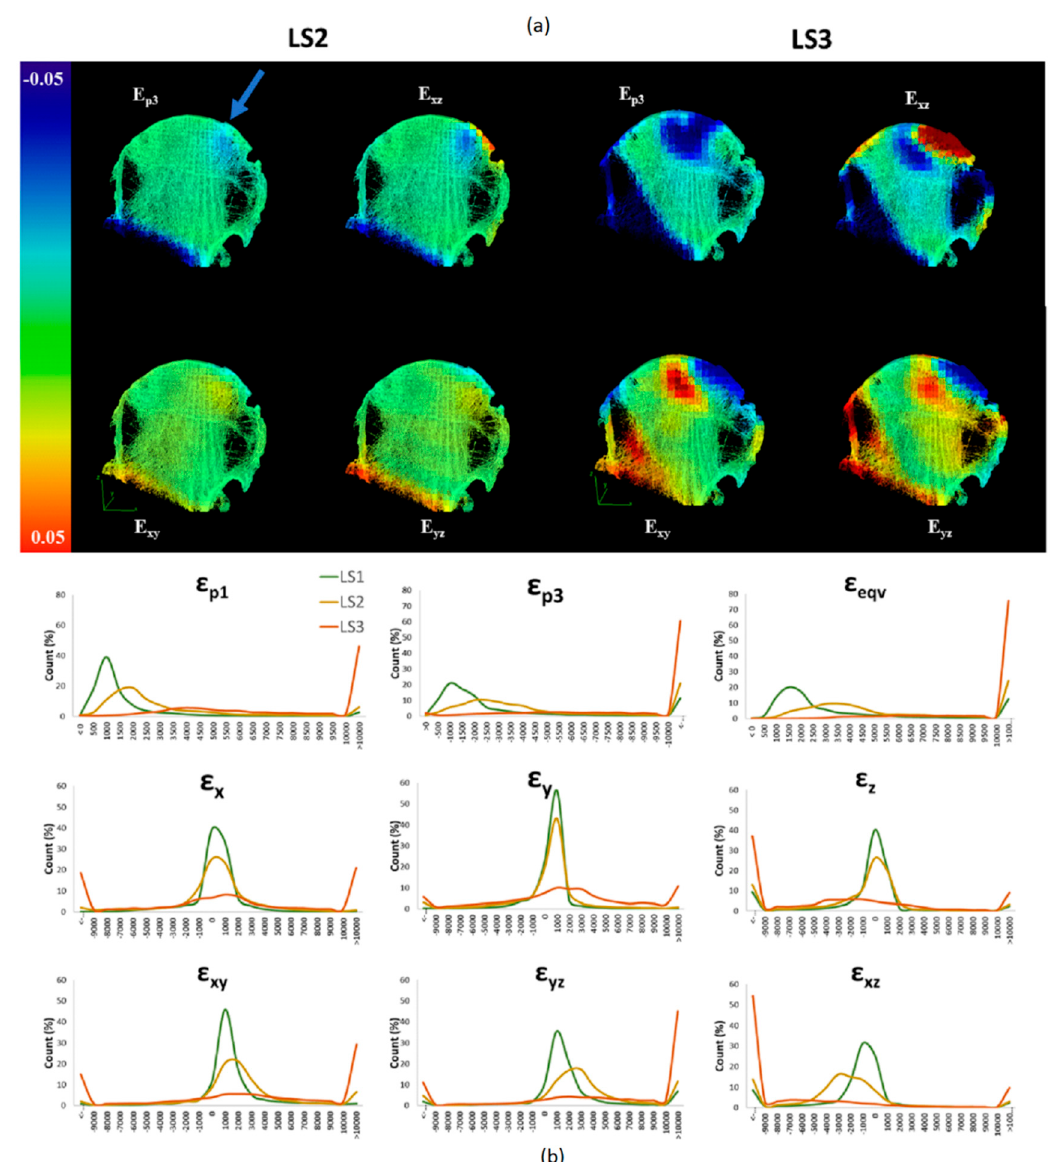
Figure 5. ( a ) 3D Renderings of 5 mm thick slices of Specimen 1 overlaid with the DVC output strain maps for ( ε p3, ε xy, ε yz and ε xz). The images qualitatively illustrate the localisation of strain at LS2 (~3 kN) (LEFT) and increase and propagation of strains at LS3 (~ 6 kN) (RIGHT). The load was applied on the superior side of the femoral head (blue arrow) perpendicular to the cut surface of the femoral neck. ( b ) Histograms illustrating frequency distribution for strain components ( ε p1 ε p3 ε eqv ε x ε y ε z ε xy ε yz ε xz) and incremental load steps (LS1 (green), LS2 (yellow) and LS3 (orange). Large volumes of bone exceeding the yield strain of bone (10,000 µε ) are present at the apparent yield load step (LS3).